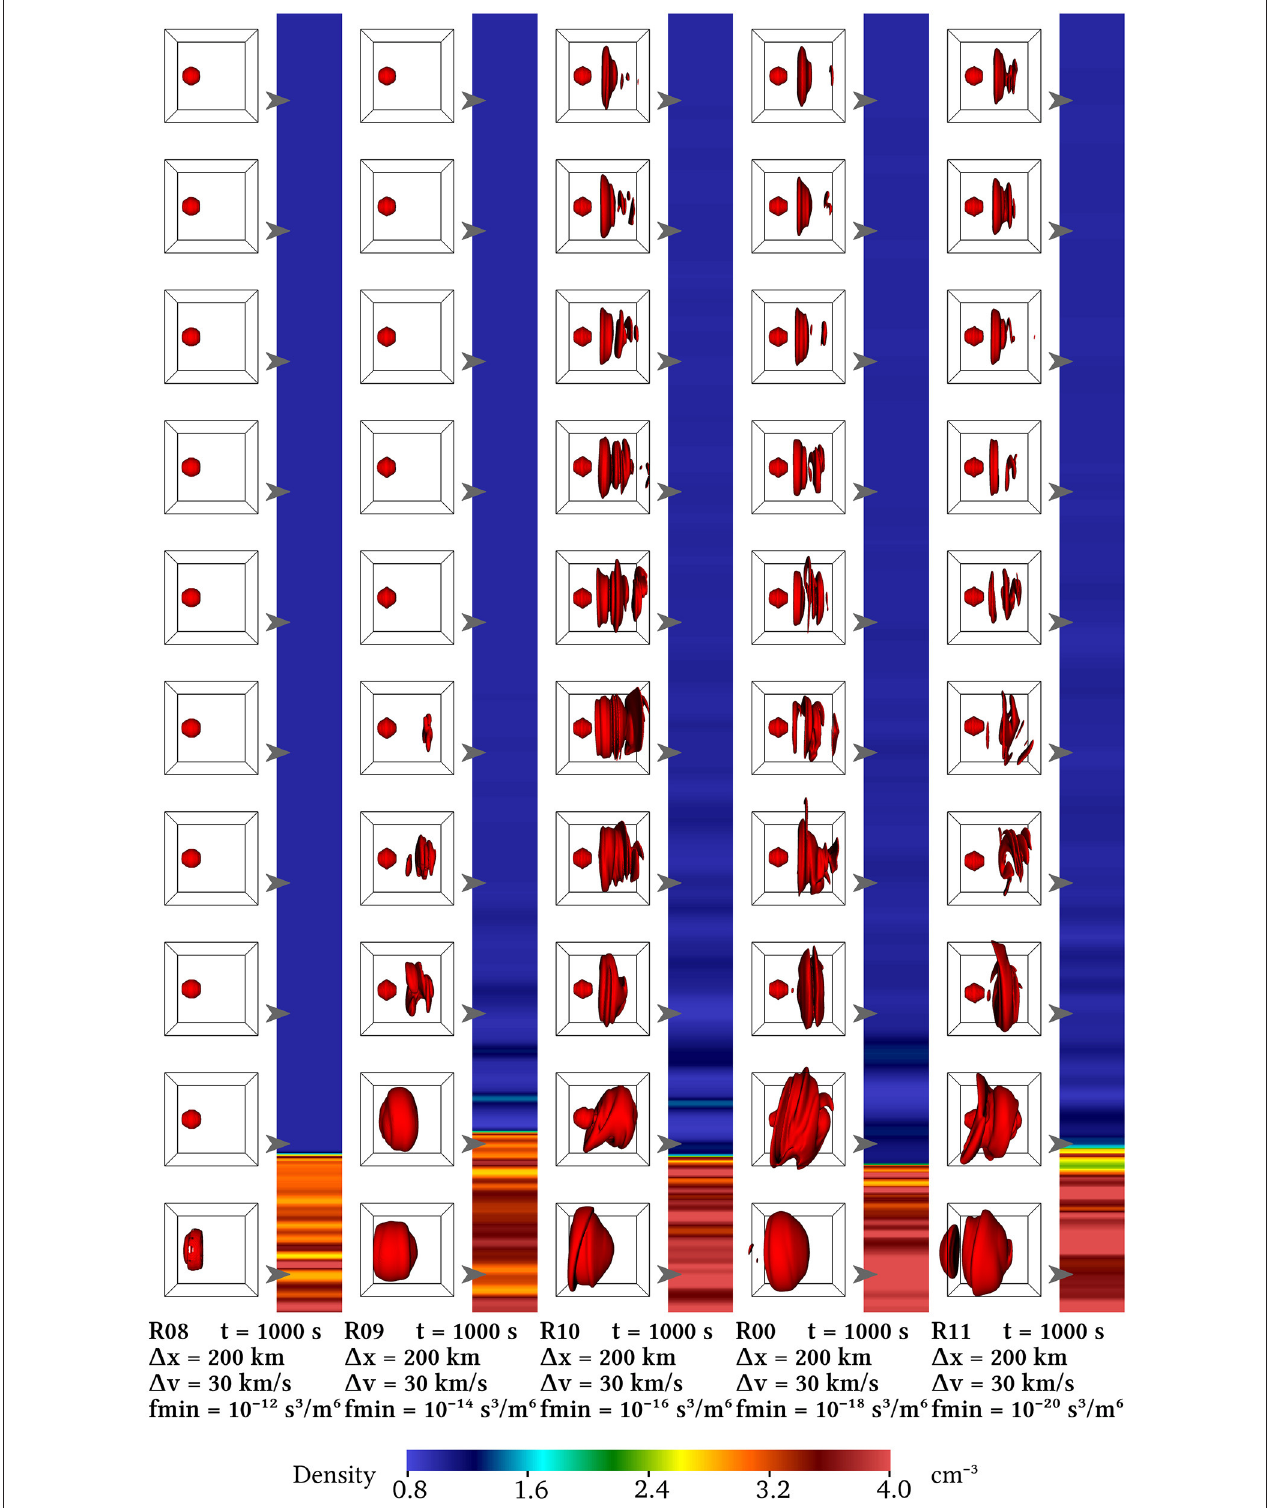
FIGURE 3 | Runs R08, R09, R10, R00, and R11 showing the effect of decreasing f min . For the given resolution parameters, the result of the shock simulation is converging, as can also be seen in the corresponding Supplemental data Animation A2 and Figure 4 .